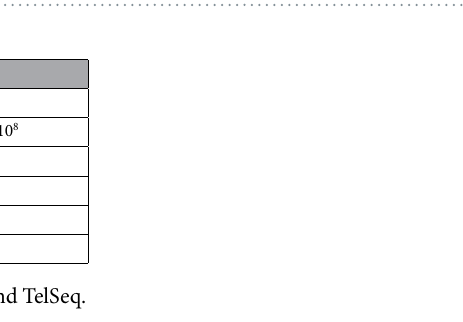
Table 3. Benchmarking results for Telomerecat and